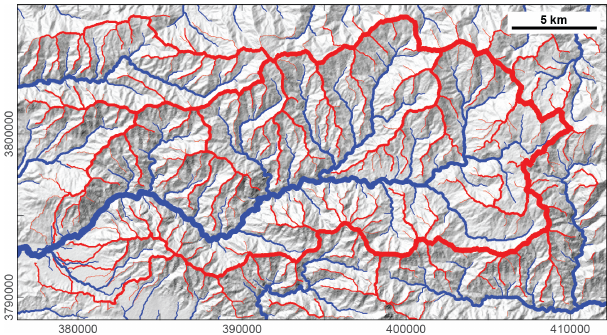
Figure 1. The Big Tujunga catchment, San Gabriel Mountains, United States, with the stream network (blue) and drainage divide network (red) draped over hillshade image. The drainage divide net- work is obtained with the approach developed in this study. The thickness of the stream and divide lines is related to upstream area and divide order, respectively. Divide orders are based on the Topo ordering scheme, which we describe in the main text. The map pro- jection is UTM zone 11. North is